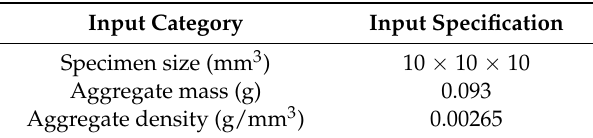
Table 7. Sieve distribution of the mortar-a4 scale.